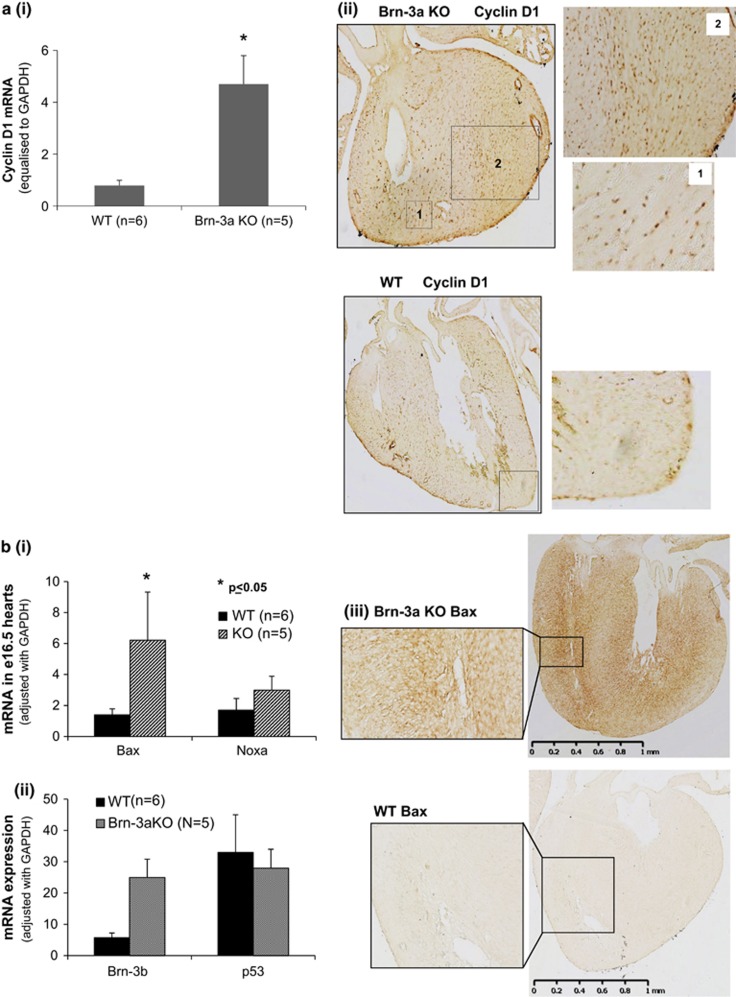
(a): (i) Results of qRT-PCR showing changes in cyclin D1 mRNA levels in e16.5 WT or Brn-3a KO hearts. Values were adjusted with the housekeeping gene, GAPDH and represent the mean and S.E. of 3–4 independent samples. *Indicate statistical significant changes using t-test with P⩽0.05. (ii) Representative immunostaining images of cyclin D1 protein in heart sections from e17.5 Brn-3aKO embryos or WT controls. The main heart images were taken at × 2.5 magnification, whereas boxed sections are shown at higher magnification (× 10). (b): (i) Results of qRT-PCR showing levels of mRNA encoding Bax or Noxa in WT (black bar) or Brn-3a KO (grey bar) in e16.5 hearts. Values were adjusted with the house keeping gene, GAPDH, which was amplified using the same cDNA samples and represent the mean and S.E. of 3–4 independent samples. *Indicates statistically significant changes (<P=0.05), using t-test. (ii) Results of qRT-PCR showing changes in Brn-3b mRNA or p53 in hearts taken from WT (black bar) or Brn-3a KO (stippled bars) at e16.5. Values were adjusted with the house keeping gene, GAPDH and represent the mean and S.E. of 3–4 independent samples. (iii) Representative images of heart sections from e17.5 Brn-3aKO or WT control embryos, immunostained for Bax protein. Whole-heart images were taken at × 2.5 magnification, whereas boxed sections are shown at higher magnification (× 10). (c) Representative images showing TUNEL staining in e17.5 hearts taken from (i) WT controls or (ii) Brn-3a KO embryos. Dark brown staining indicates cells with TUNEL positivity. Whole-heart images were taken at × 2.5 magnification, whereas boxed sections are shown at higher magnification (× 10)